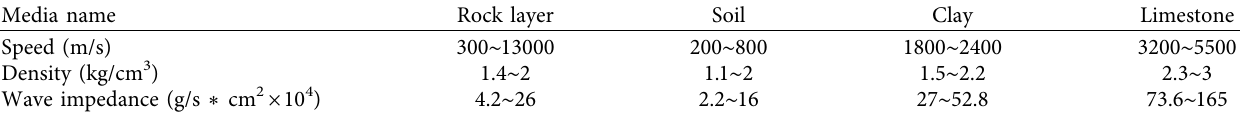
Table 1: Propagation speed and wave impedance of waves in different